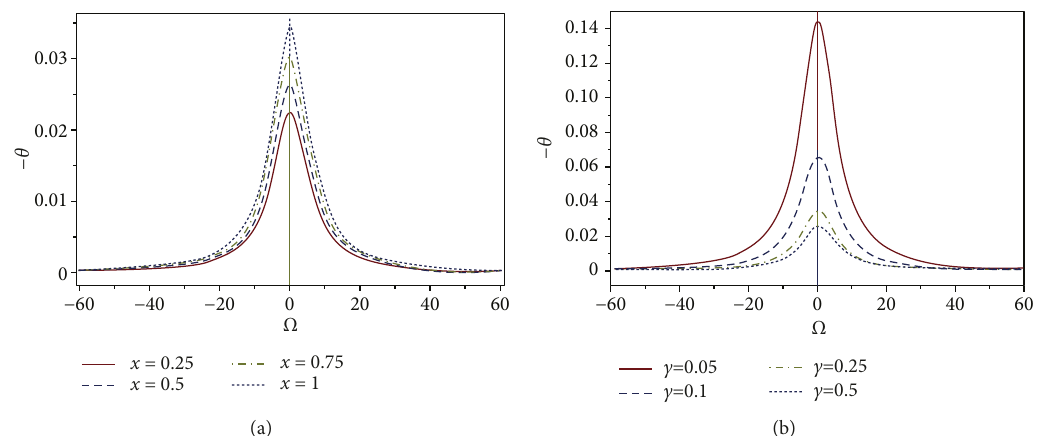
Figure 3: (a) Universal dispersion coe ffi cient plotted against the dimensionless orthogonal fi eld, Ω , and ̂ x = 0 5 , z = − 1 , and γ = 0 5 for various values of the dimensionless axial position, ̂ x . (b) Universal dispersion coe ffi cient plotted against the dimensionless orthogonal fi eld, Ω , and ̂ x = 0 5 , z = − 1 , and α = 5 for various values of the aspect ratio, γ .